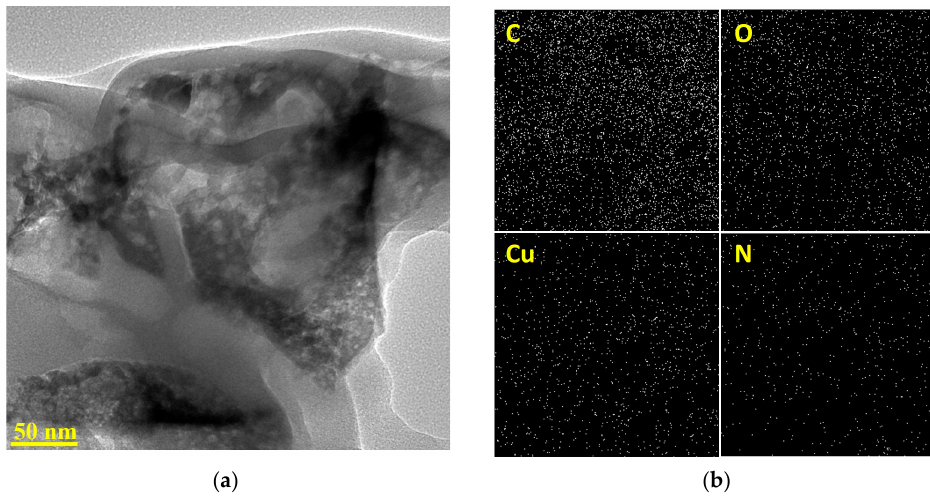
Figure 2. ( a ) HRTEM image of Cu/Cu x O-PCC-0h ( b ) elemental mapping of the Cu/Cu x O-PCC-0h (unleached PCC).